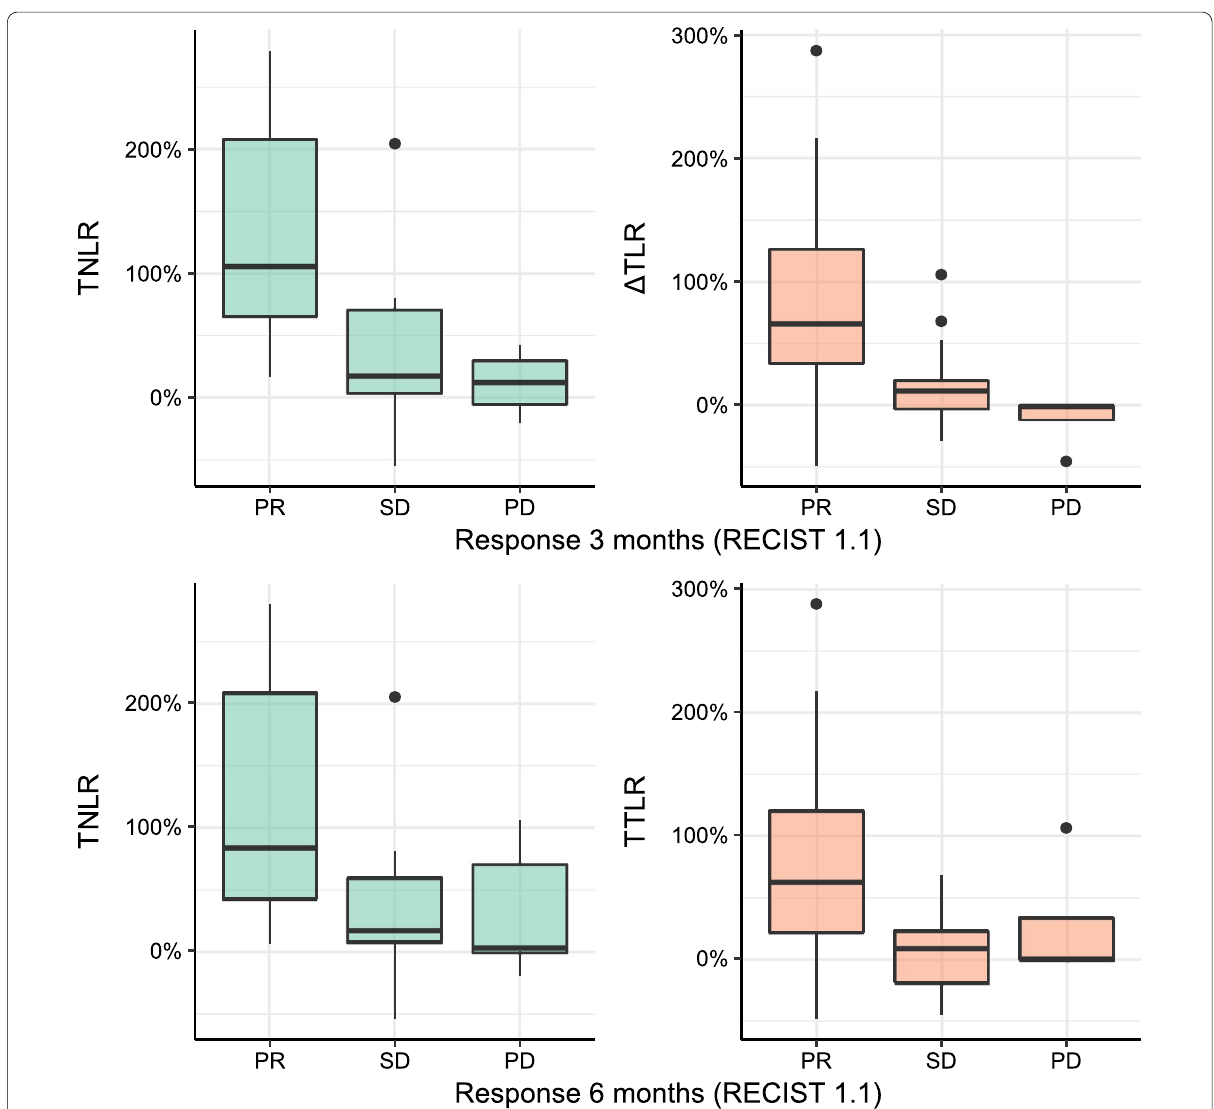
Fig. 3 Differences in relative change in NLR and TLR at 3-weeks follow-up after [ 166 Ho]-radioembolization plotted against response according to RECIST 1.1 at 3 months (top-left and top-right) and 6 months (bottom-left and